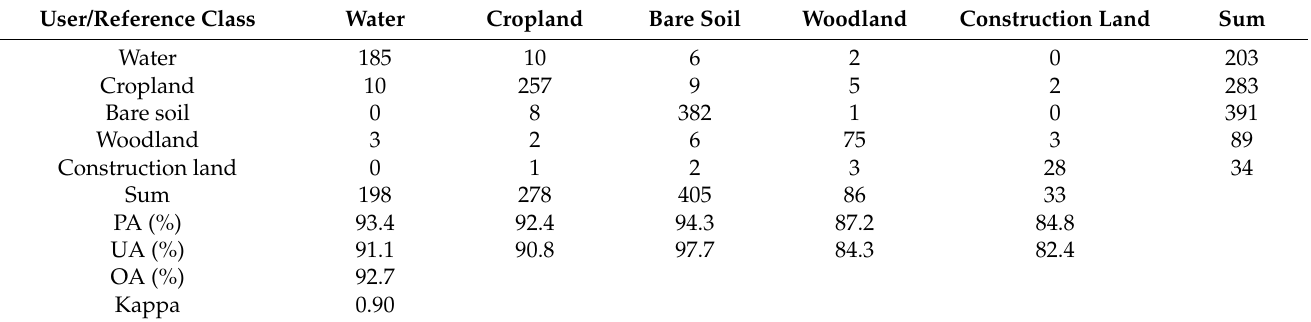
Table 3. Accuracy assessment of the land cover classification of the flooded area.